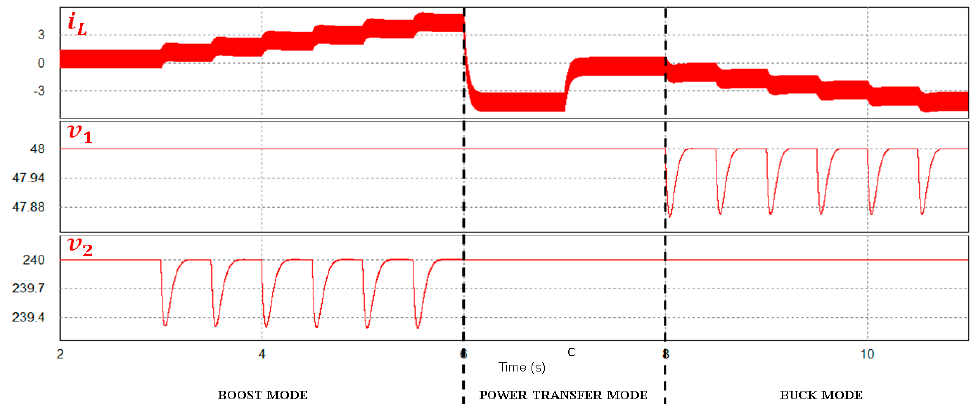
Figure 14. Test validating complete operation of the unified multimode control, including changes between modes: boost mode (2–6 s)  power transfer mode (6–8 s)  buck mode (8–11 s). between modes: boost mode (2–6 s) → power transfer mode (6–8 s) → buck mode (8–11